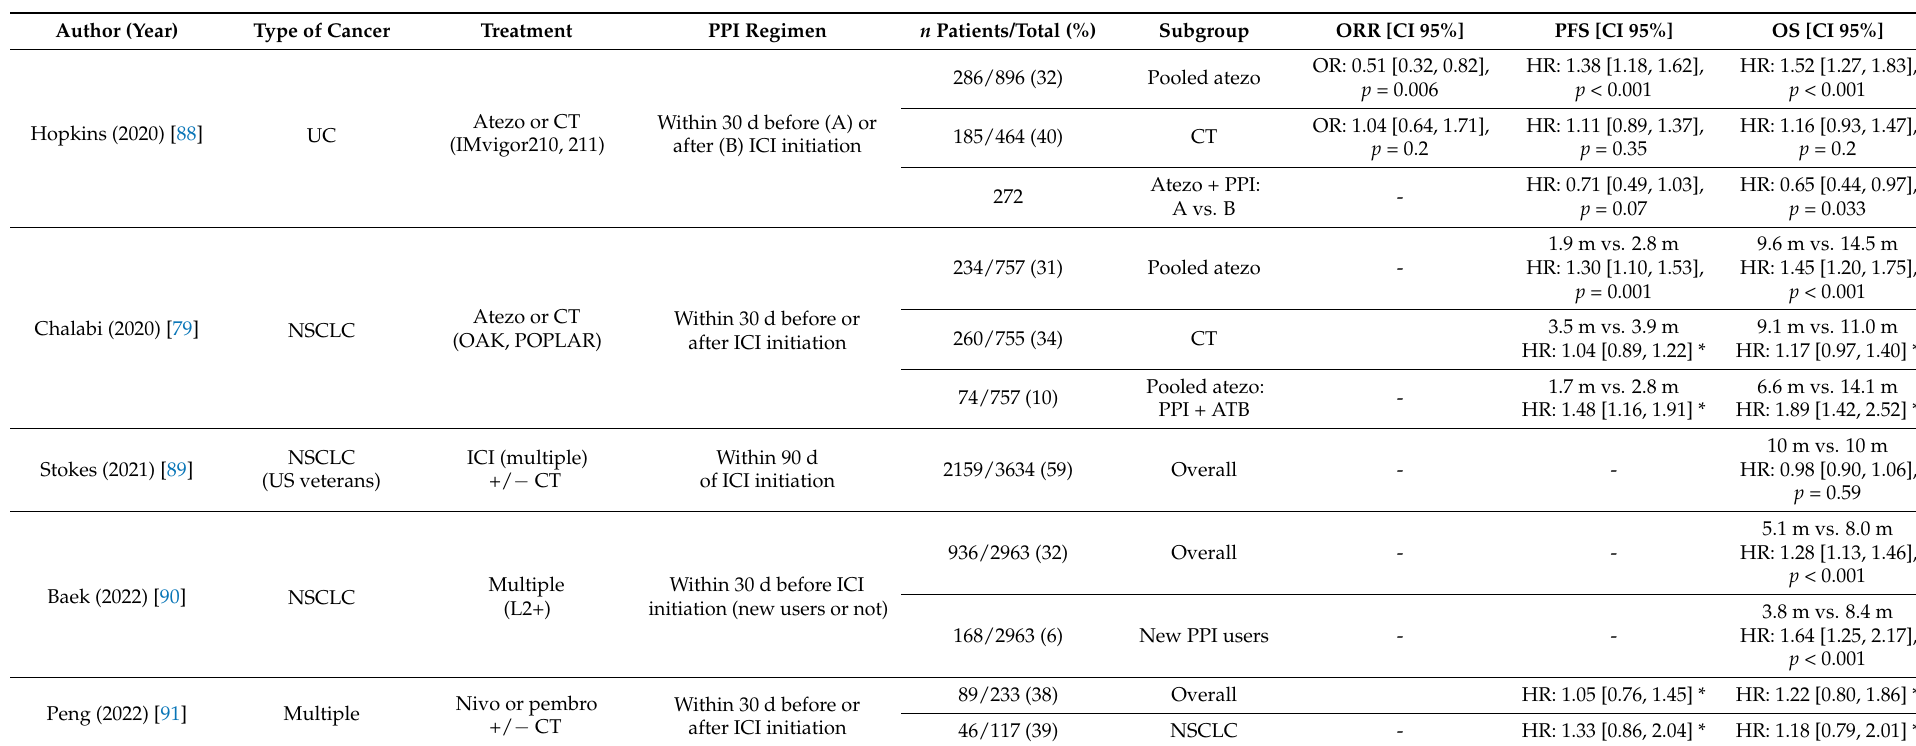
Table 5. Studies analyzing the impact of proton pump inhibitors on response rate and survival with ICI and/or chemotherapy treatment